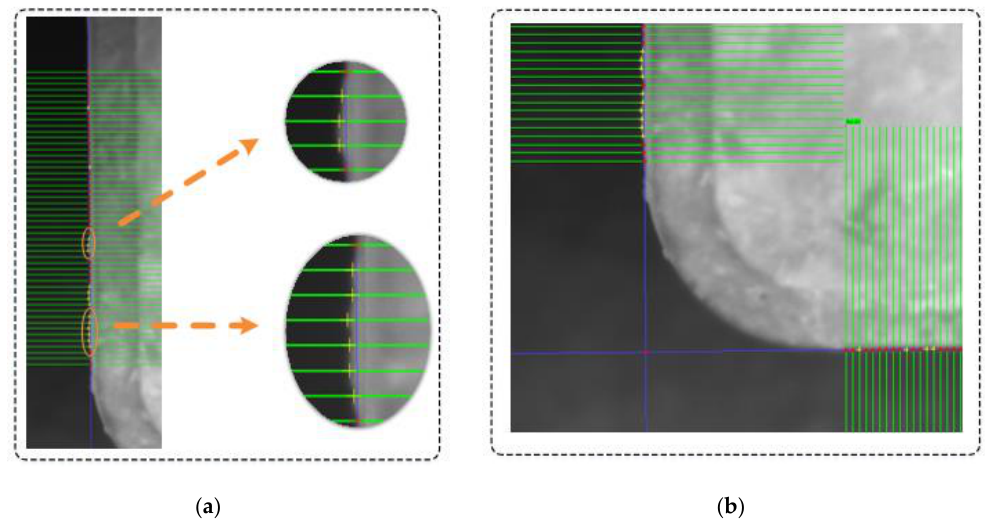
Figure 14. Outlier detection effect and edge fitting effect in the real image: ( a ) effect of outlier detection after zooming in on a local area of the image, with outliers marked in yellow and inliers marked in red; ( b ) obtained track plate position information based on edge straight line.